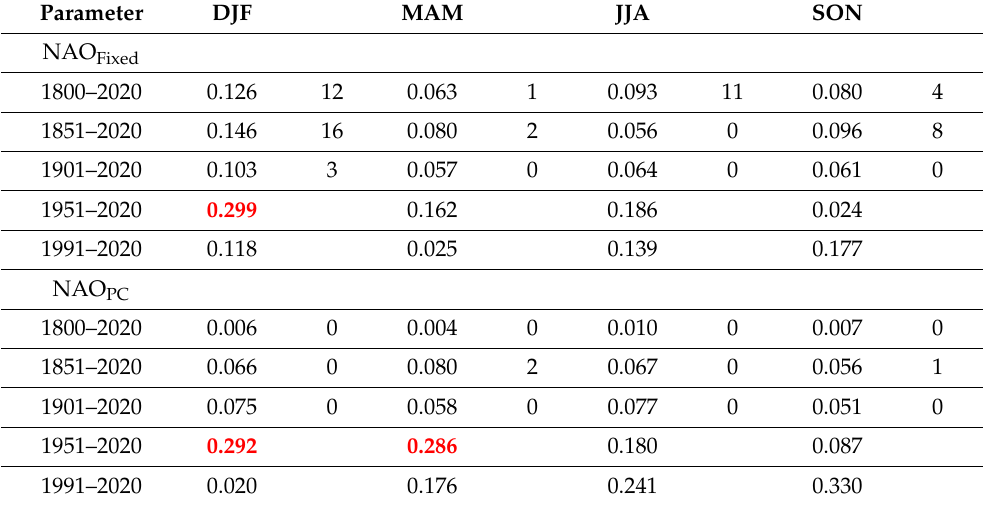
Table 1. Cont. Parameter